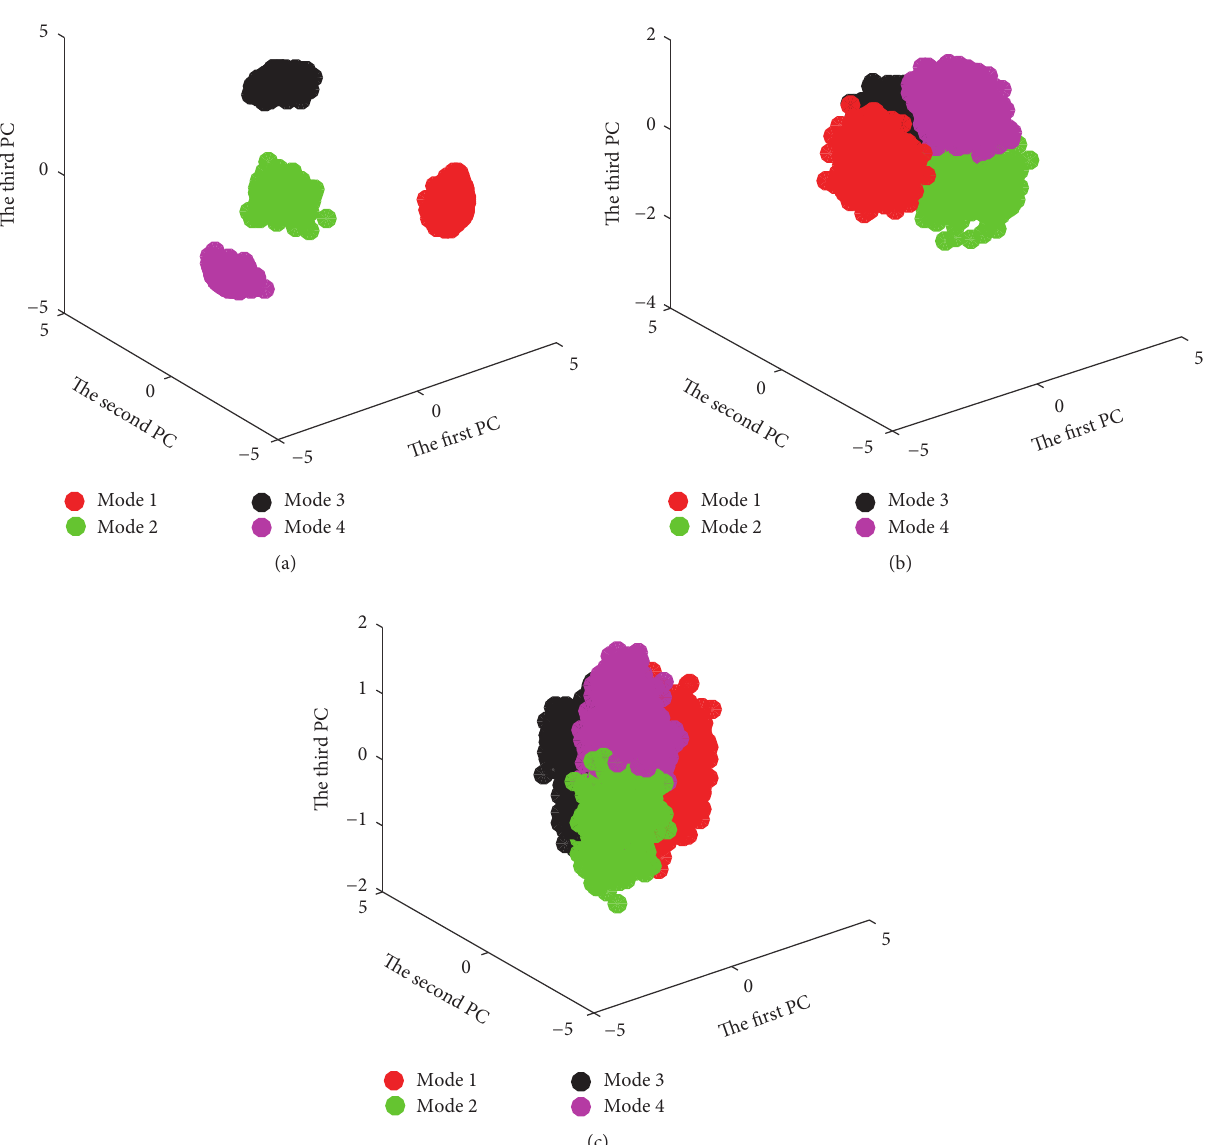
Figure10:Scatterplotsofprincipalcomponentsformodepartitionfeatures;(a)–(c)representmodepartitionresultcorrespondingtoHDNN, HBPNN, and HSVM,